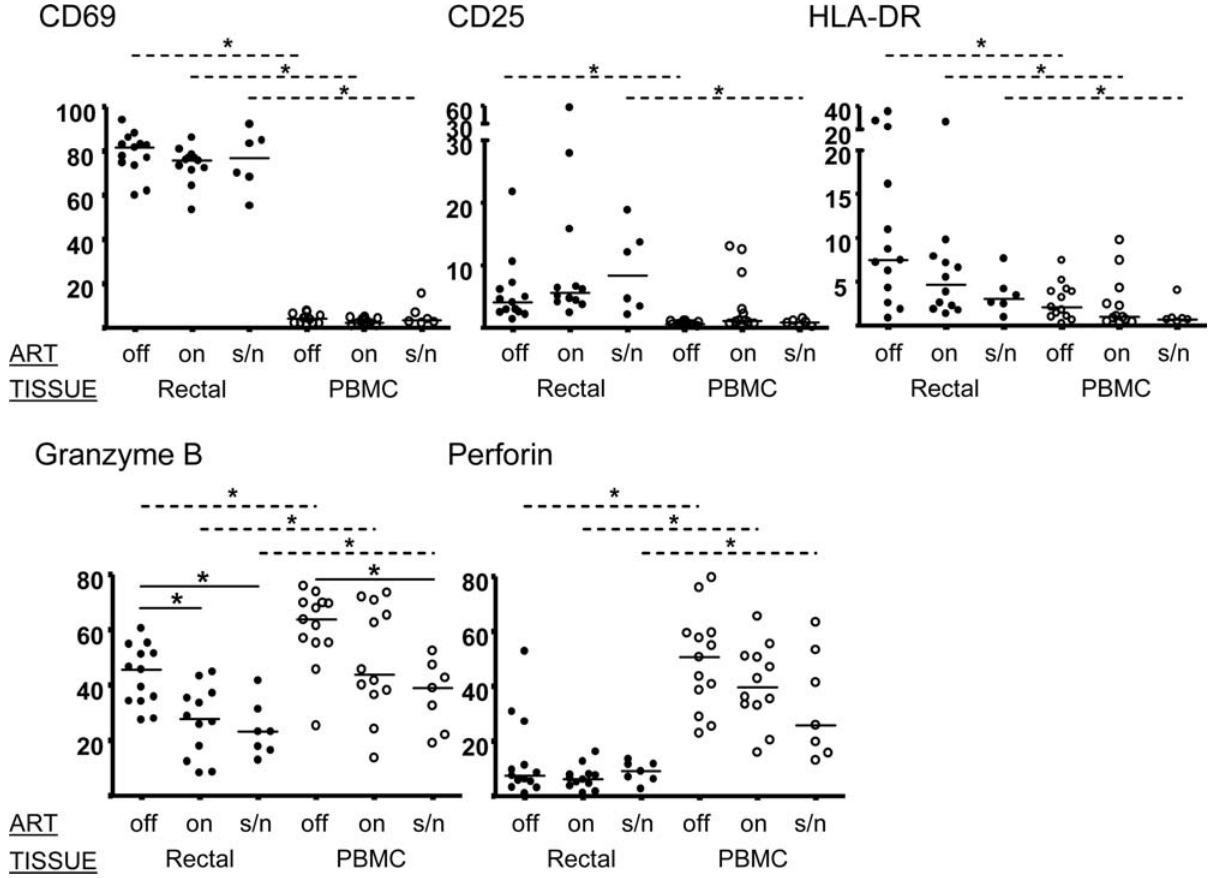
Figure 8. Phenotypic features of CD8 + T-cells from PBMC and rectal mucosa. Unstimulated cells were stained for surface markers and intracellular antigens and analyzed by flow cytometry. The percentage of CD8 + T-cells positive for each marker is given on the Y-axis. Median values are indicated by a horizontal line. Statistically significant differences between groups ( p , 0.05) are denoted by an asterisk with solid line (Kruskal- Wallis) or broken line (Paired T-test). Rectal mucosa (filled circles); PBMC (open circles); ‘off’, not on ART; ‘on’, on ART; s/n,